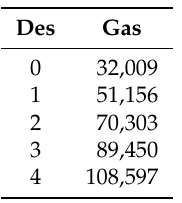
Table 10. Gas Used in BlendCAC’s allChildrenRevocation() ABI.